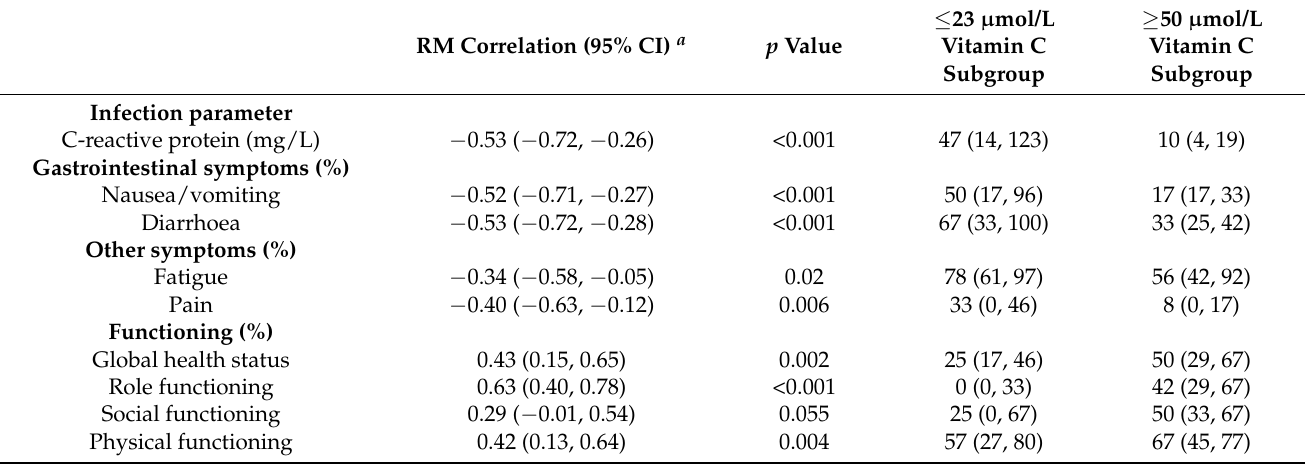
Table 2. Repeated measures correlations between vitamin C status and post-transplantation symp- toms and